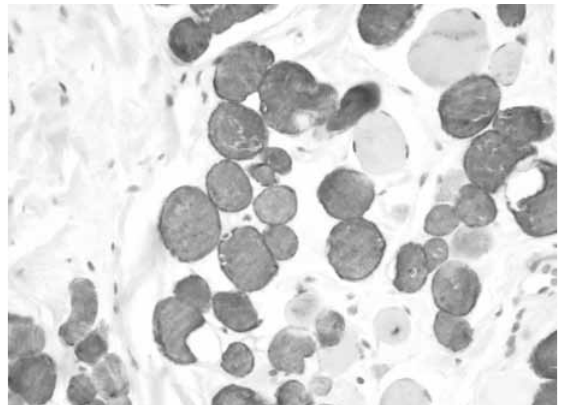
figurE 5 – IHC study shows positivity for HHF35 in the skeletal muscle fibers IHC: